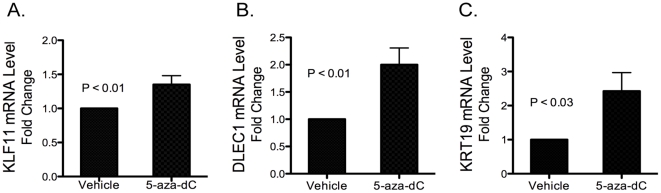
Effect of DNMT inhibitor 5-aza-dC on KLF11, DLEC1 and KRT19 expression in leiomyoma smooth muscle cells.(A) KLF11, (B) DLEC1 and (C) KRT19 mRNA levels were quantified by real-time RT-PCR after treatment of cultured uterine leiomyoma smooth muscle cells with vehicle or 5-aza-dC (3 µM) for 5 days. mRNA levels were normalized first to GAPDH and then, to those in vehicle-treated cells. Experiments were performed in triplicate samples, and the data are representative of samples from seven different subjects. The data are shown as the mean +/− SEM. P<0.05 as compared with vehicle treatment.